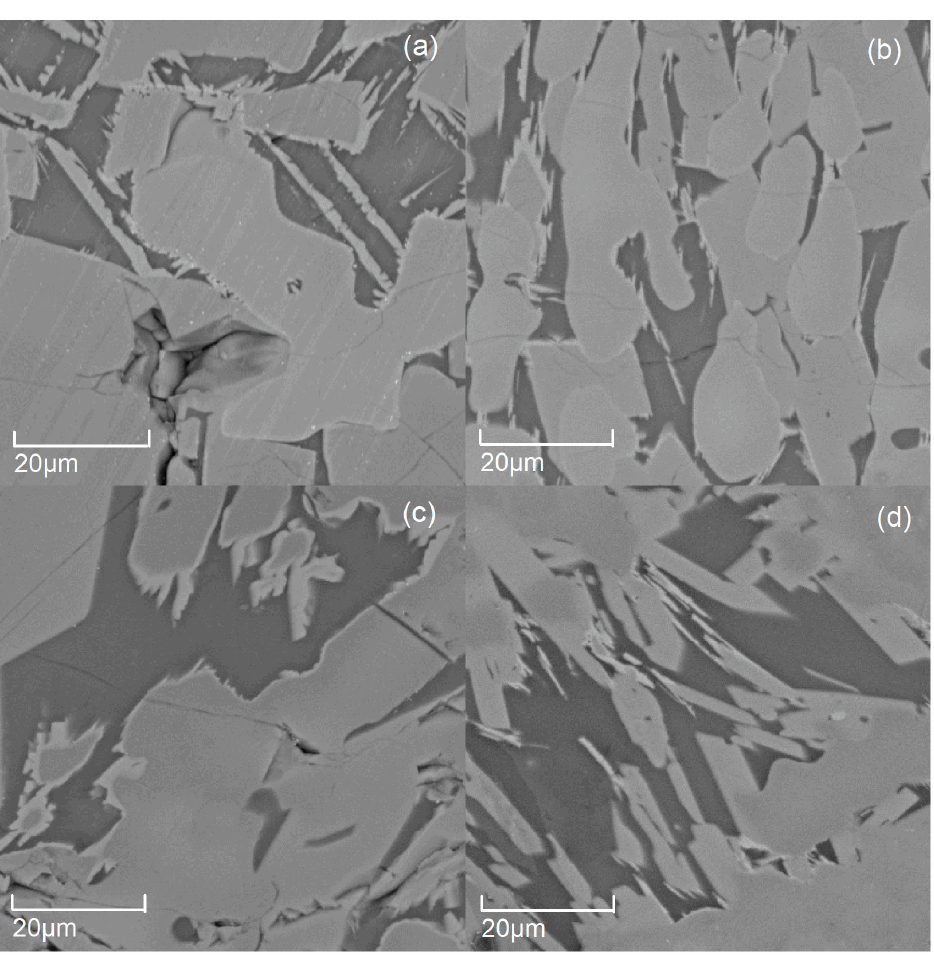
Figure 1. Micromorphology of the modified titanium slag with different additive (B 2 O 3 ) amounts: